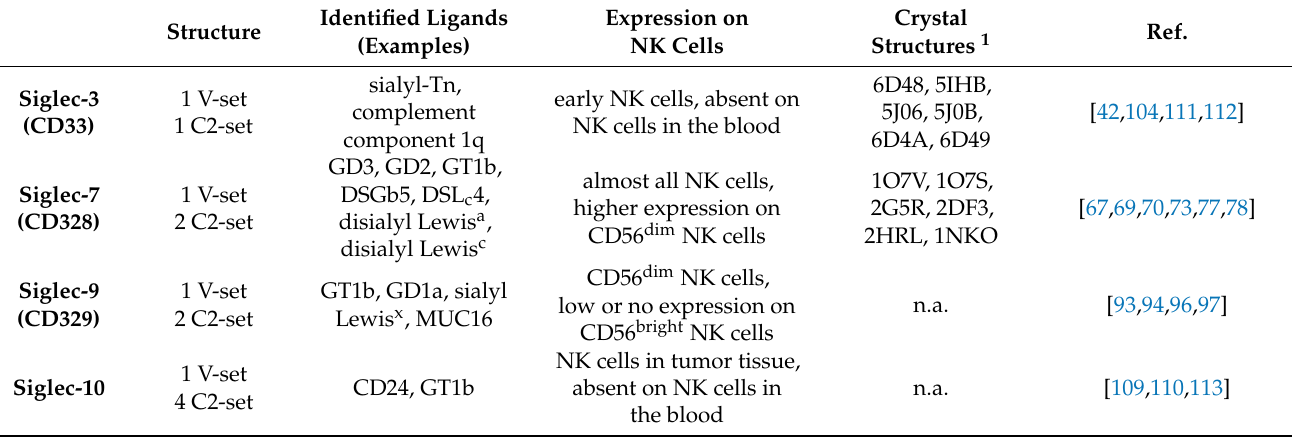
Table 1. Siglecs on NK